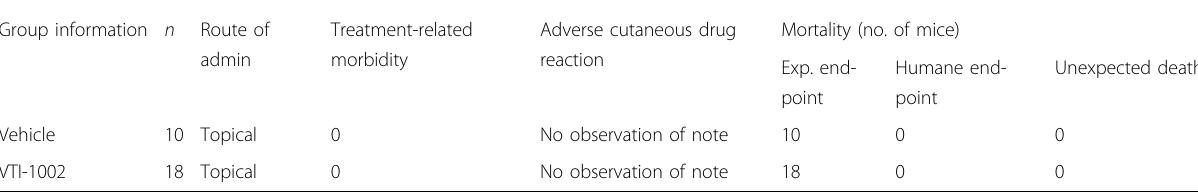
Table 2 VTI-1002 in vivo safety data Group information n Route of